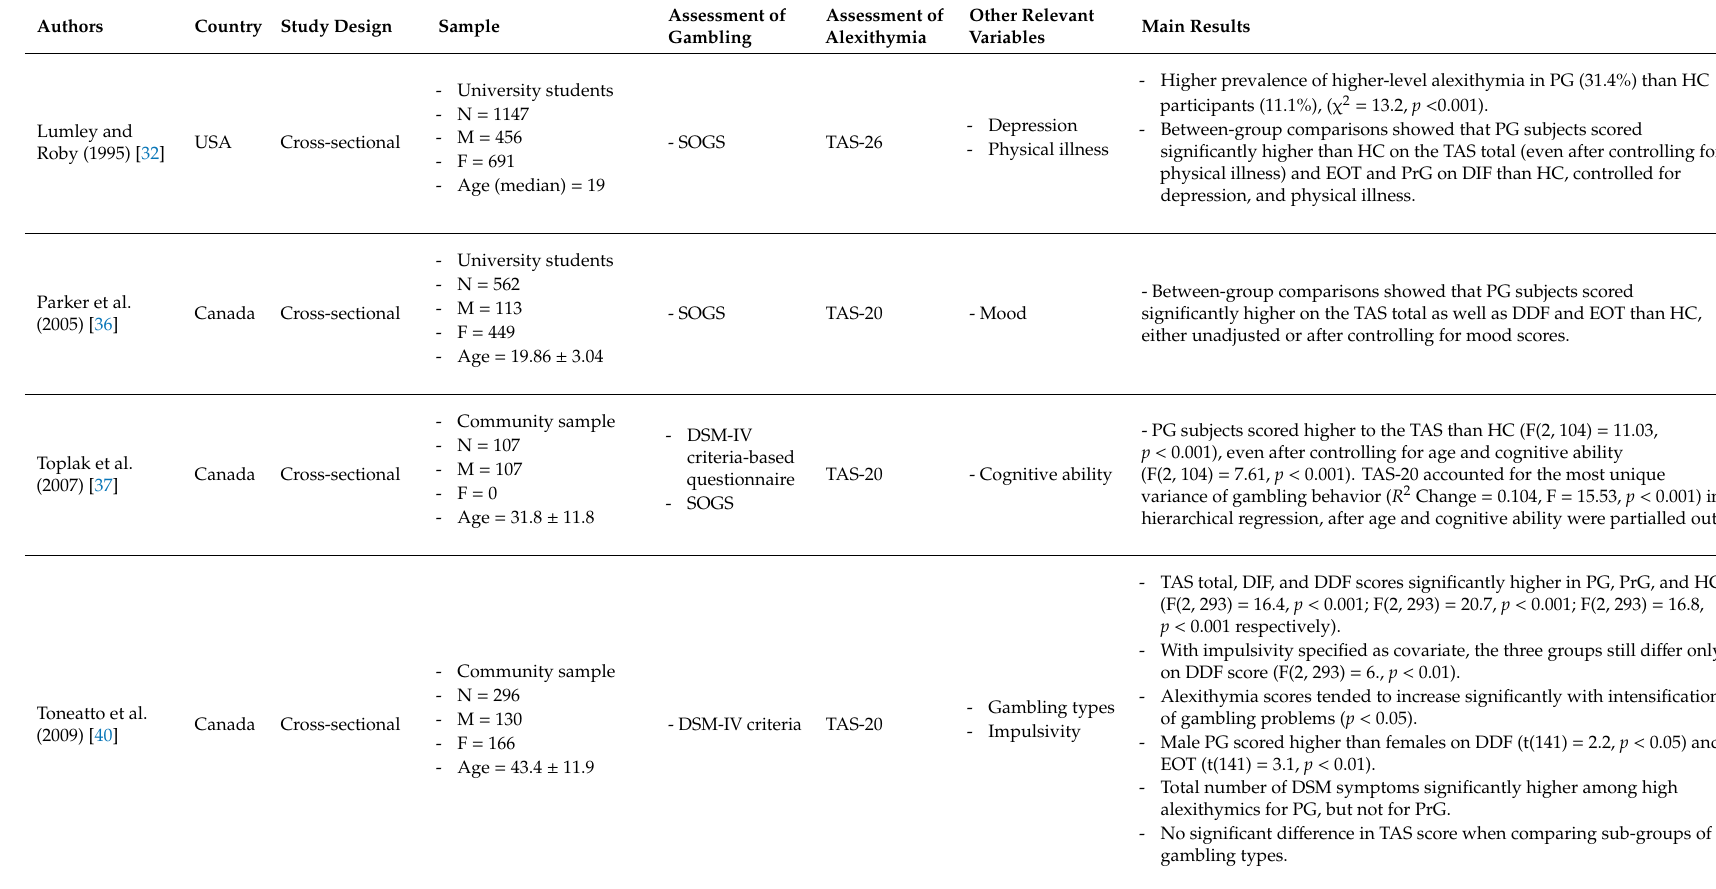
Table 1. Studies on alexithymia and gambling in community